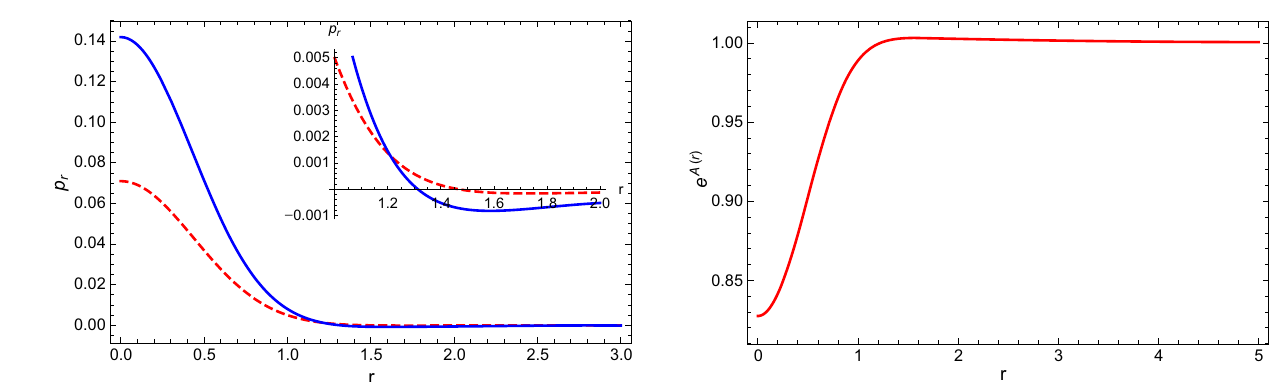
Fig. 5 e A ( r ) as a function of r with M = 0 . 1 , θ = 0 . 1 values of M , θ . The temperature of this NCBH